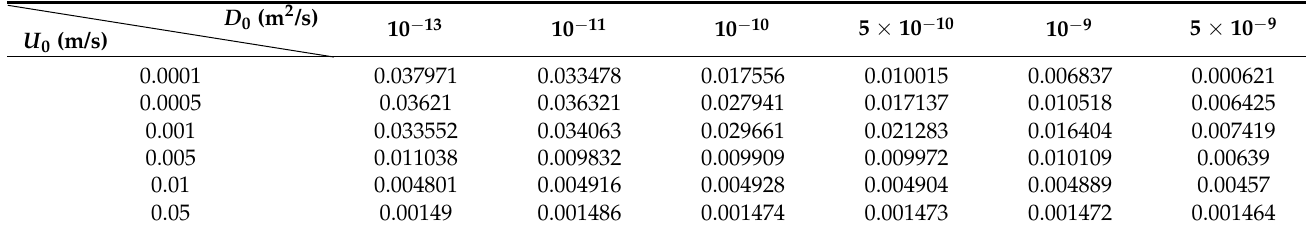
Table 2. Raw data of NUC of thirty-six simulated